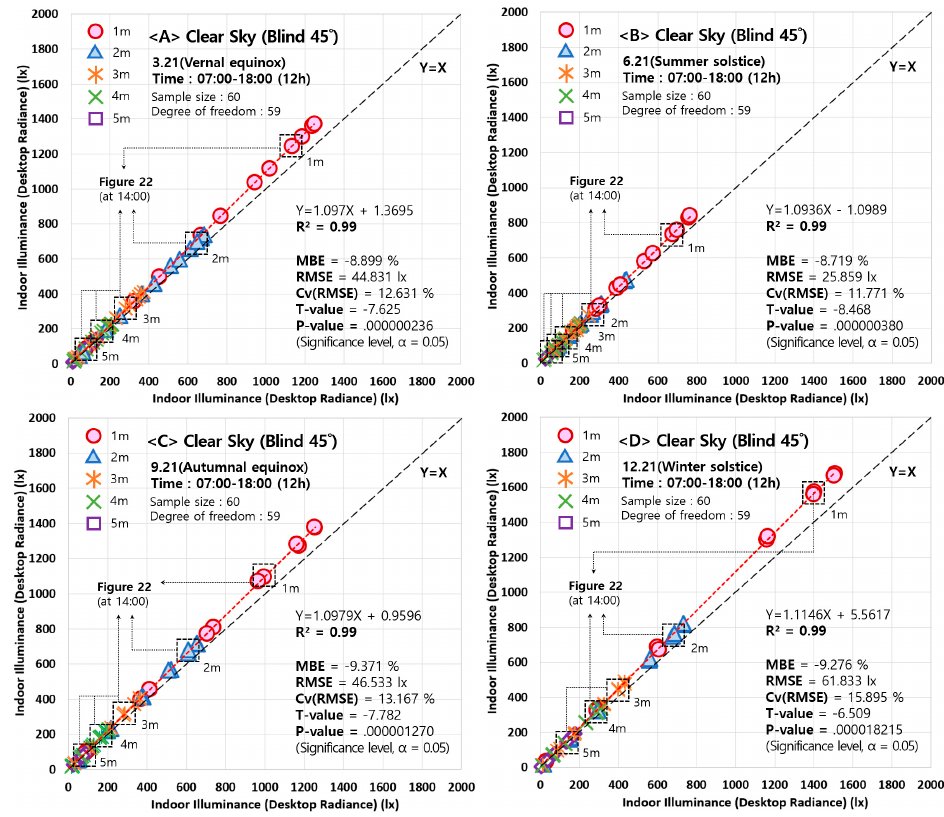
Figure 23. Comparison of indoor illuminance between the modified equation and Desktop Radiance simulation when installing external venetian blind 45° ( A ) 3.21 ( B ) 6.21 ( C ) 9.21 ( D ) 12.21 (07:00–18:00).